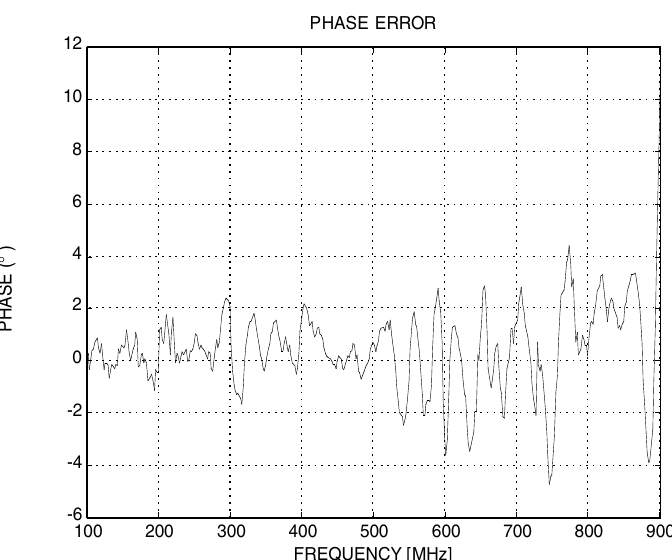
Fig. 11. Absolute error (degrees) between the nominal and the registered phase of a test signal versus